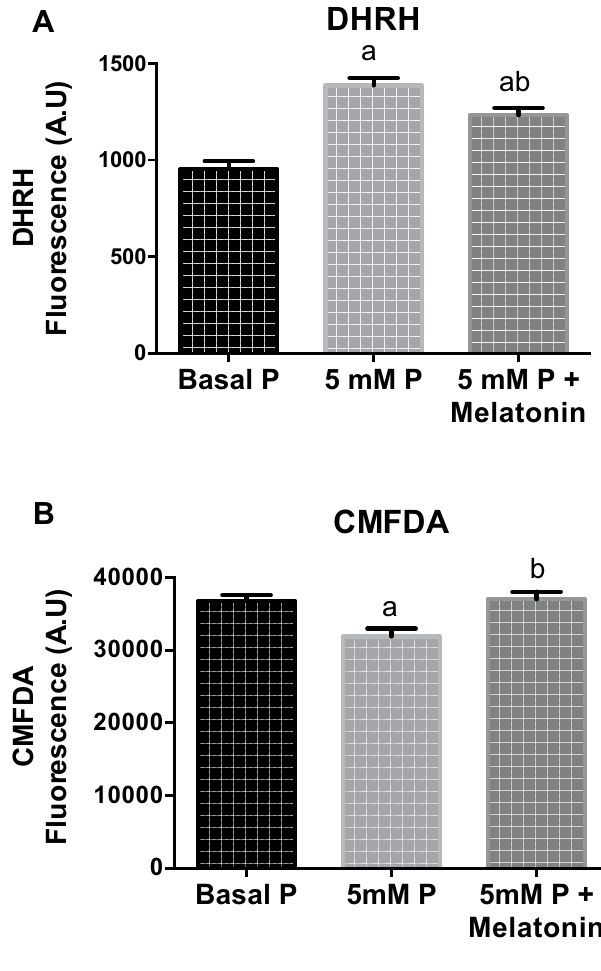
Figure 8. In HEK-293 cells, the addition of melatonin prevents oxidative stress induced by high levels of inorganic phosphate. Intracellular ROS were determined by using the probes ( A ) DHRH and ( B ) CMFDA after 24 hours of incubation in a medium containing normal P concentration (0.9 mM), high levels of phosphate (5 mM P) and high phosphate plus melatonin (10 − 5 M). a p < 0.001 vs normal phosphate; b p < 0.001 vs 5 mM